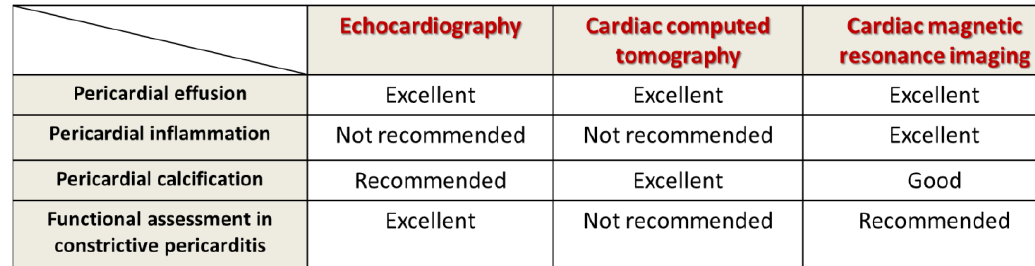
Figure 3. Multimodal imaging evaluation in tuberculous pericarditis (adapted after [111]). Karima et al. [112] analyzed a group of 25 patients with constrictive pericarditis